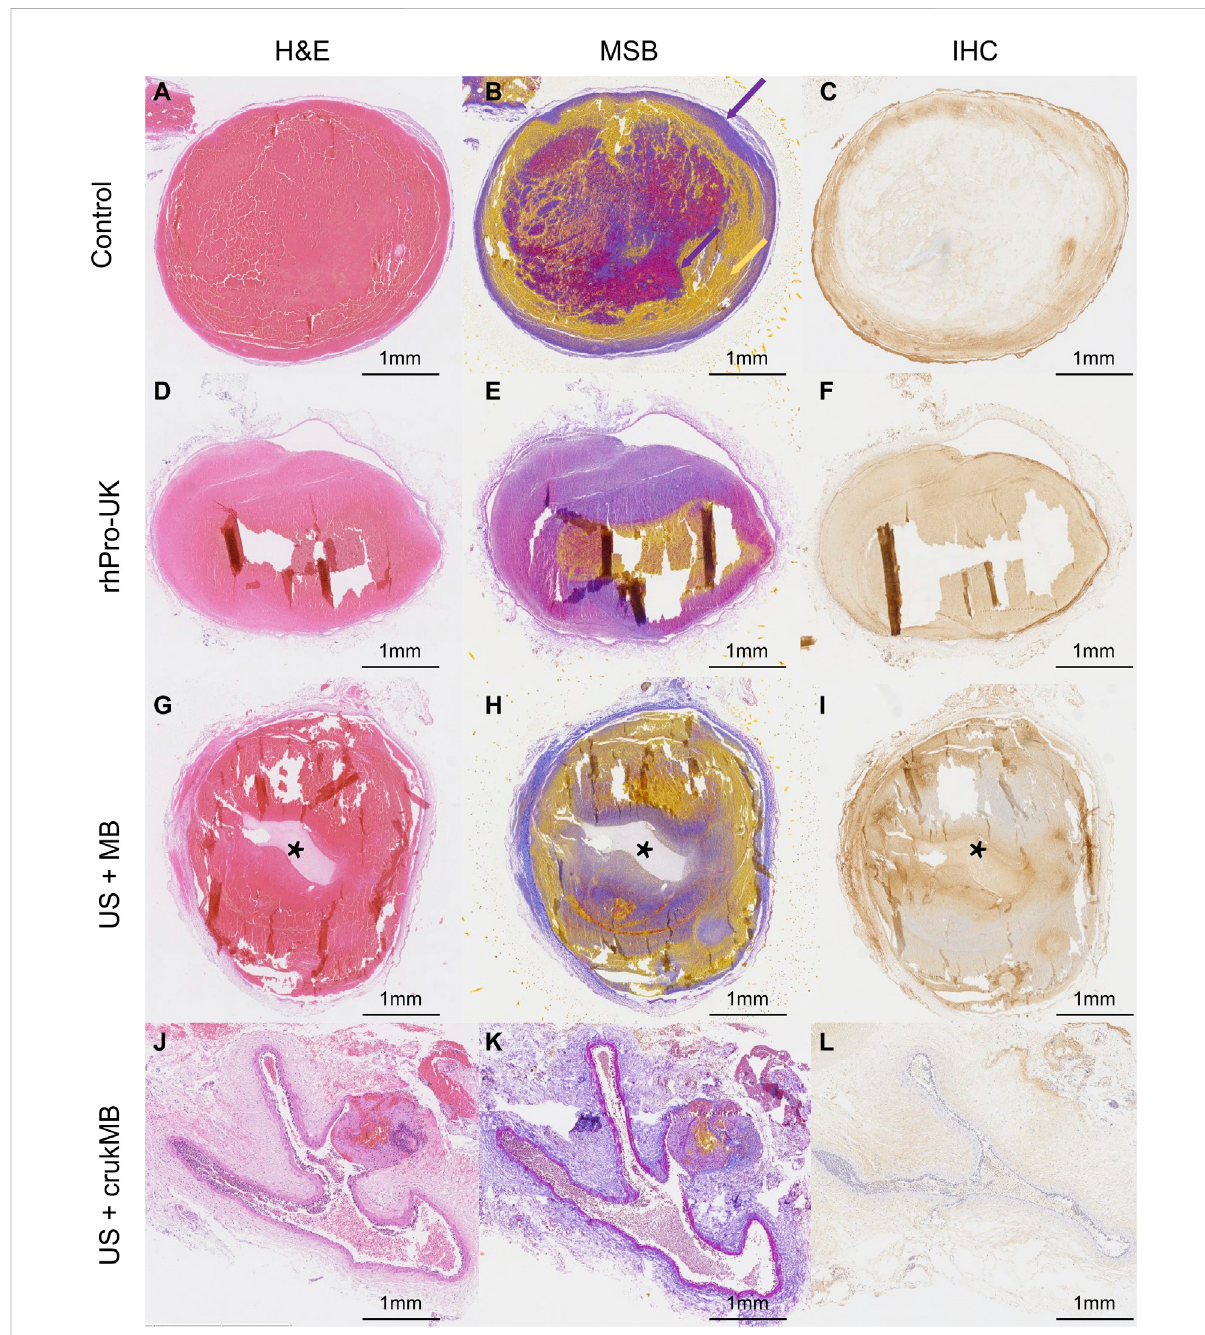
Histological analysis of post-treatment thrombus. Fibrin and red blood cells depositions were indicated by purple color and yellow color, respectively (purple- and yellow-colored arrows in panel (B) . The tunnels [asteroids in panels (G – I) ] in the US + MB group were the results of treatment. The lumen of IVC in the US + crukMB group was collapsed as indicated in panels (J-L) , due to a nearly complete clearance of thrombus. (scale bars, 1